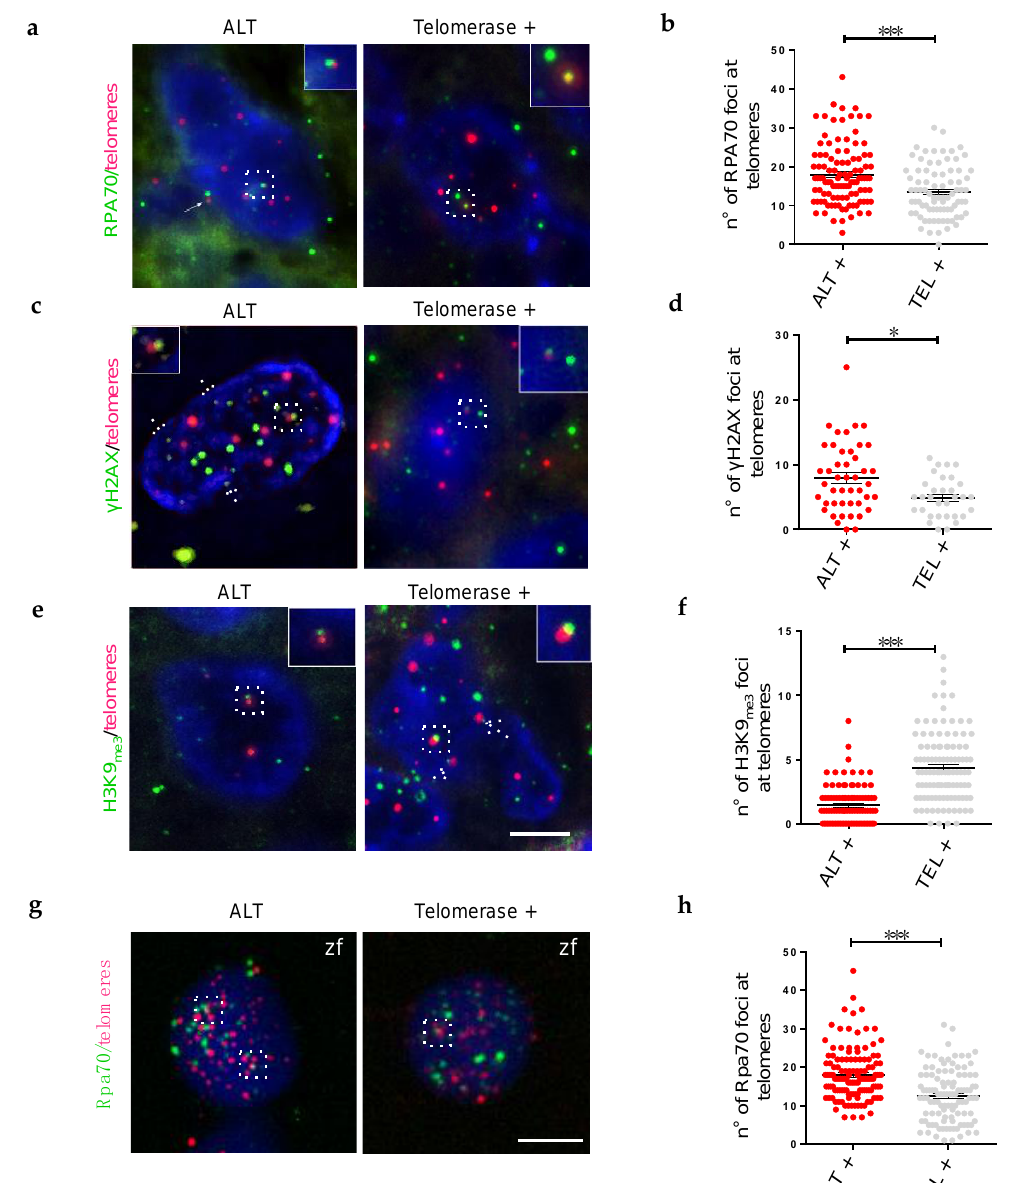
Figure 5. The presence of telomerase leads to a reorganization of telomeric chromatin, decrease DDR and replication stress. ( a , c , e ) Fluorescent microscope images of a single plane of focus of representative ALT, and telomerase + human brain tumor cells, stained by immunofluorescence (green) combined with Q-FISH (magenta). Antibody against replication stress marker ( a , RPA70), DNA damage marker ( c , γ H2AX), and chromatin methylation marks ( e , H3K9me3) were used and counterstaining with DAPI. Insets, dashed frames and arrows show co-localization of immunofluorescence and Q-FISH spots. Scale bar: 5 µ m. ( b , d , f ) Immunofluorescence quantification expressed as the number of foci per nucleus that colocalized with telomeres ( n = 25–60 nuclei) for the corresponding samples in ( a , c , e ); * p < 0.05, *** p < 0.001 between the indicated groups. ( g ) Fluorescent microscope images of representative ALT and telomerase + zebrafish brain tumor cells, stained by immunofluorescence (green) combined with Q-FISH (magenta). Antibody against a replication stress marker (RPA70), were used and counterstained with DAPI. Scale bar: 5 µ m. ( h ) Immunofluorescence quantification expressed as the number of foci that colocalized with telomeres per nucleus ( n = 25–60 nuclei) for the corresponding samples in ( g ); * p < 0.05, *** p < 0.001 between the indicated groups.